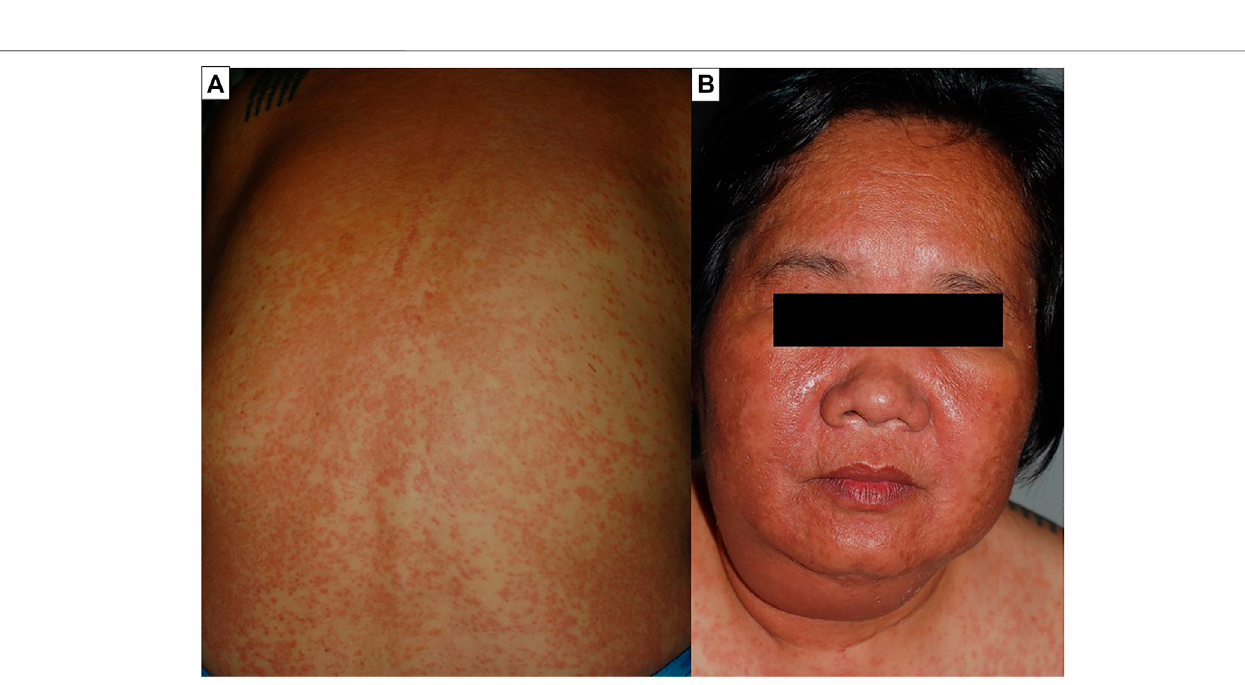
FIGURE 2 | Drug reaction with eosinophilia and systemic symptoms (DRESS). Diffuse maculopapular eruption involving more than 50% of body surface area. The plaques were in fi ltrated and exhibited follicular accentuation (A) . Facial edema is a prominent feature of the syndrome (B) .